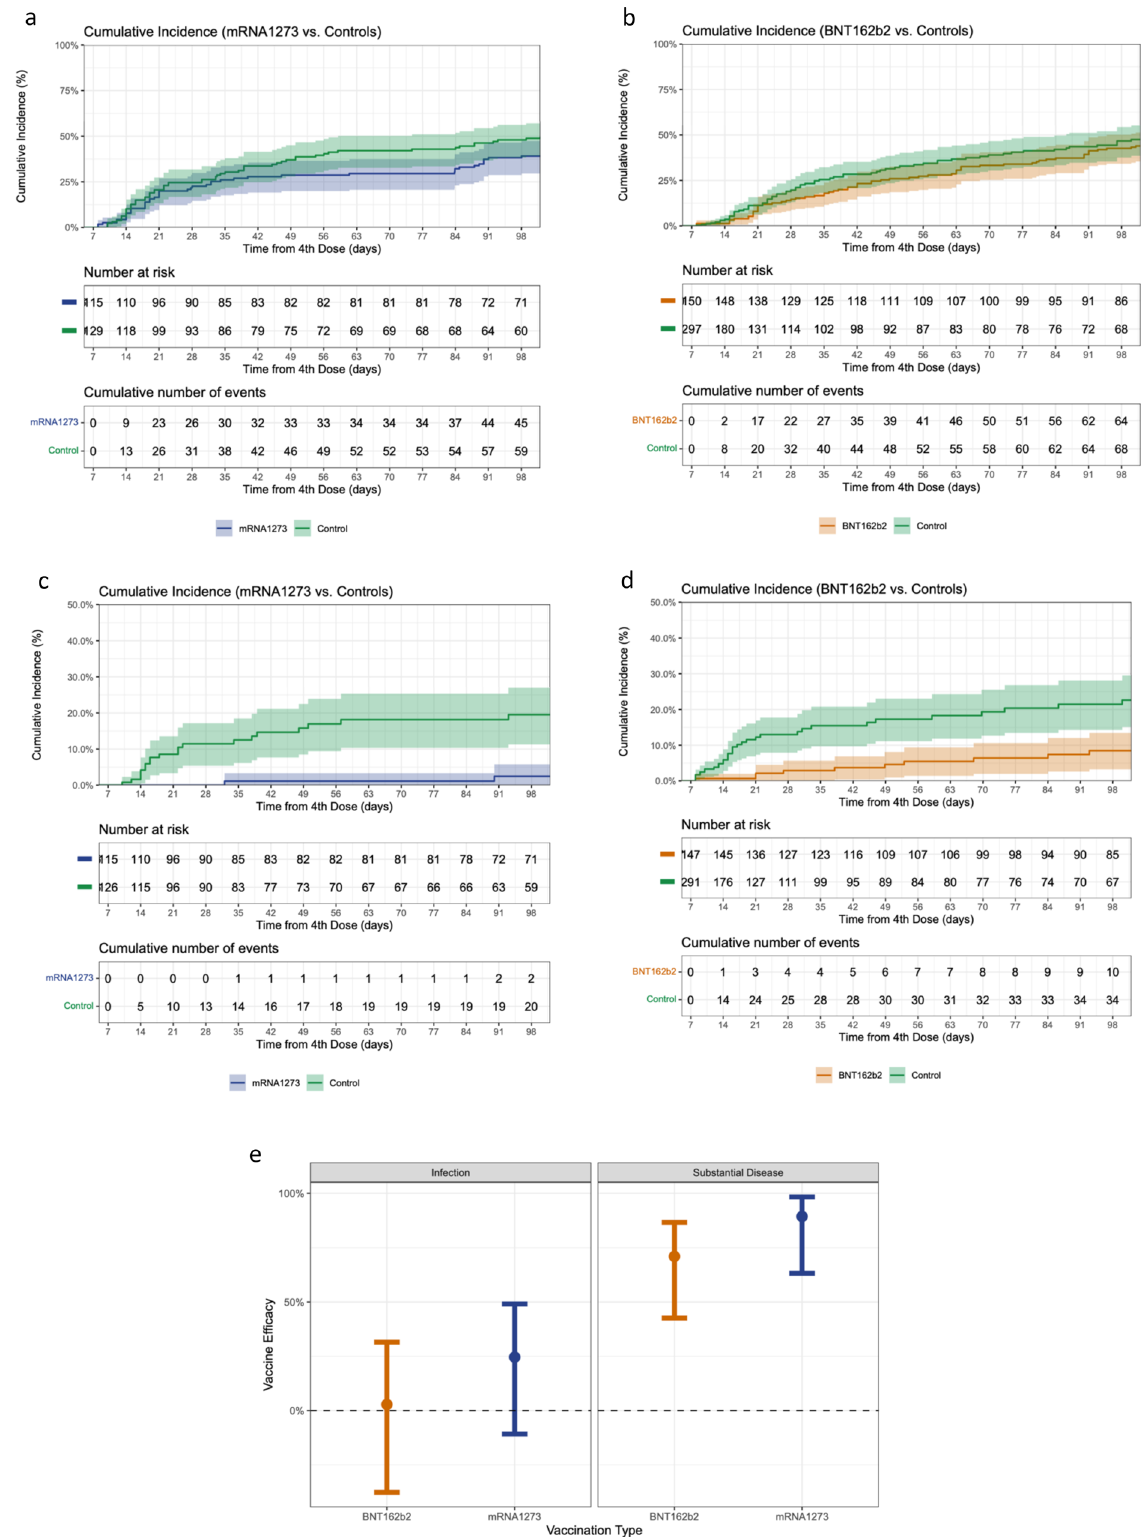
Fig. 4 | Cumulative incidence and vaccine ef fi cacy against infection and sub- stantial symptomatic disease. Cumulative incidence of a all SARS-CoV-2 infec- tions among the mRNA1273 fourth dose arm and their matched controls, b all SARS-CoV-2 infections among the BNT162b2 fourth dose arm and their matched controls, c substantialsymptomaticdiseaseamongthemRNA1273fourthdosearm and their matched controls, and d substantial symptomatic disease among the